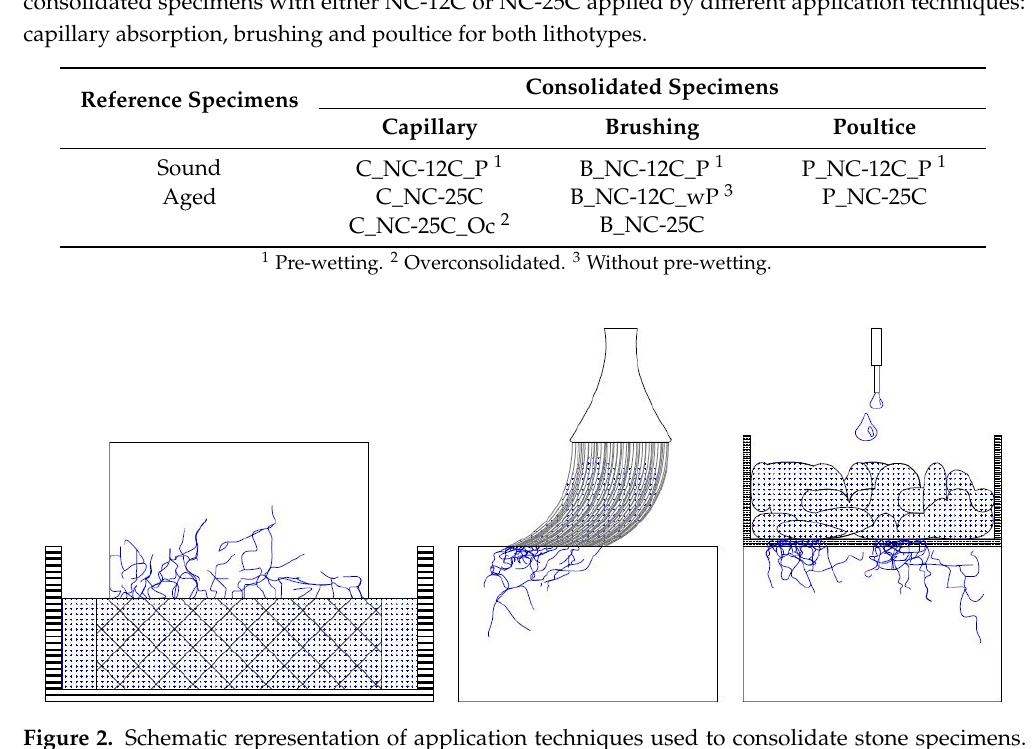
Figure 2. Schematic representation of application techniques used to consolidate stone specimens. Capillary absorption for one hour ( left ), brushing with 10 strokes ( middle ), and poultice, where a cellulose pulp packed in Japanese paper was placed on the stone surface for 1 h ( right ).